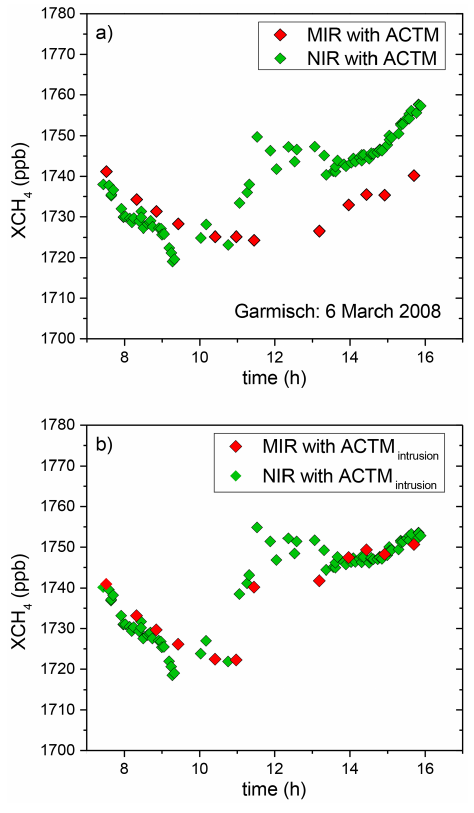
Figure 6. Garmisch XCH 4 on 6 March 2008 retrieved from FTIR data. (a) MIR and NIR retrievals are corrected to a common ACTM a priori. (b) MIR and NIR retrievals are corrected to the modified ACTM profiles shown in Fig.